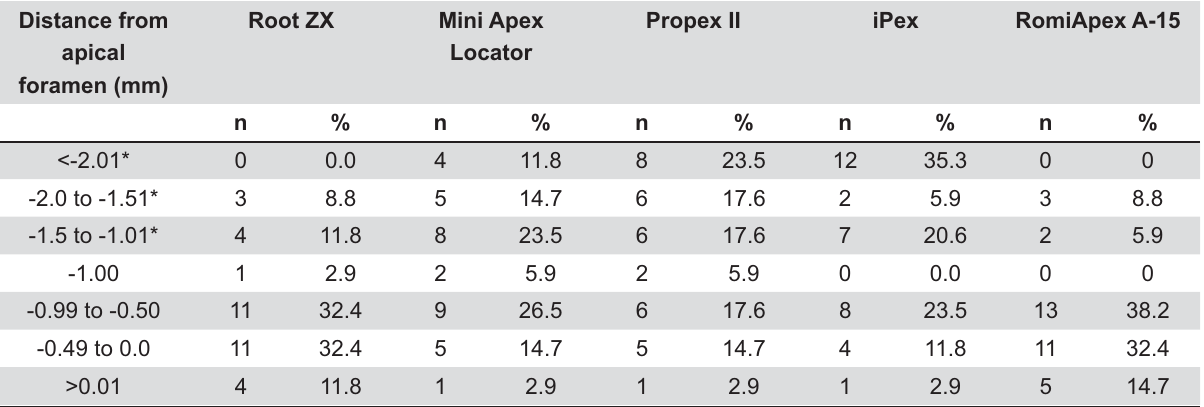
Table 3- File tip position during measurements performed short of the apical foramen (-1.0